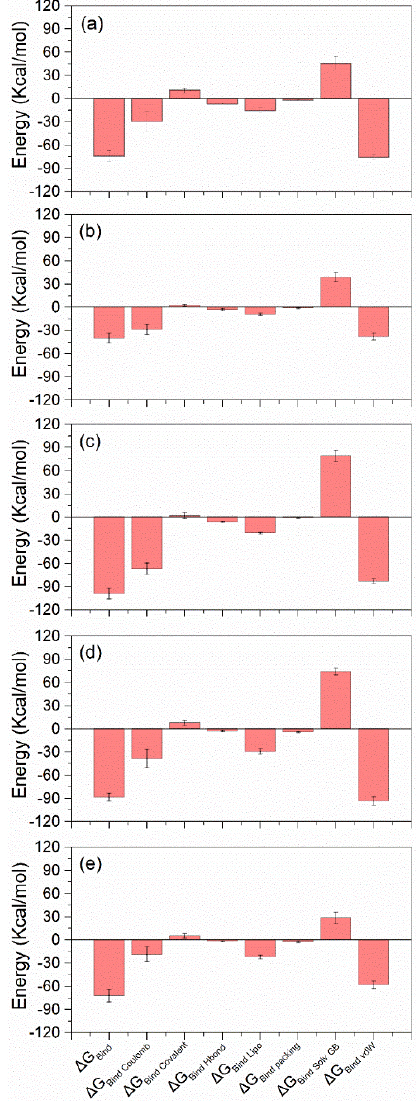
Figure 8. Protein–ligand MM/GBSA binding energy components consisting of total binding energy, columbic energy, covalent energy, H-bond energy, packing energy, solvent GB energy, and van der Waals energy calculated over the 100 ns MD simulation trajectory for ( a ) desmopressin, ( b ) rutin, ( c ) lypressin, ( d ) lanreotide, and ( e ) 68T. The interaction fraction on the Y -axis shows the percentage of a given residue involved in a specific